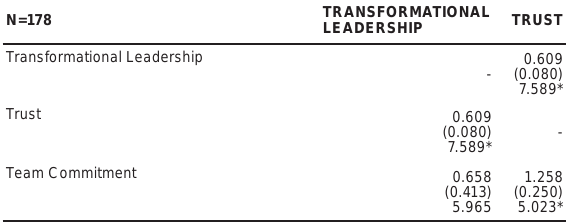
Table 4 Beta matrix: structural